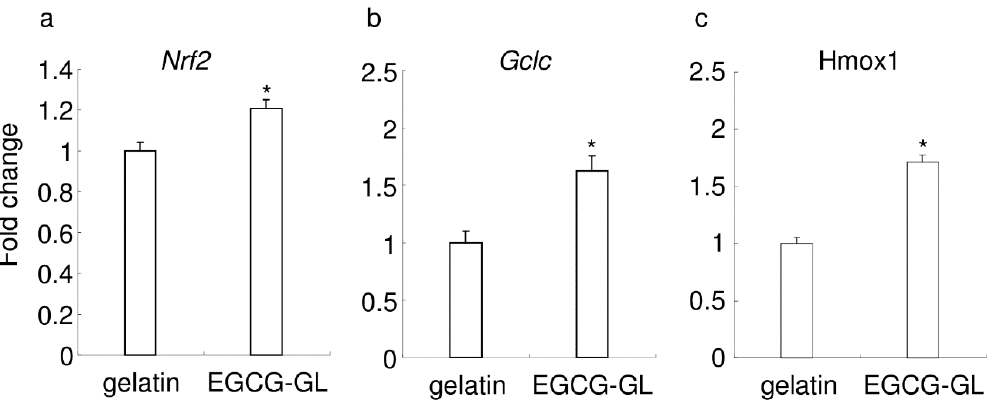
Figure 3. EGCG-GL augmented the expression of antioxidant enzyme genes. Gene expression for Nrf2 ( a ), glutamate-cysteine ligase (Gclc) ( b ), and heme oxygenase 1 (Hmox1) ( c ). (n = 3) *: p < 0.05 versus control (sample treated with gelatin solution).